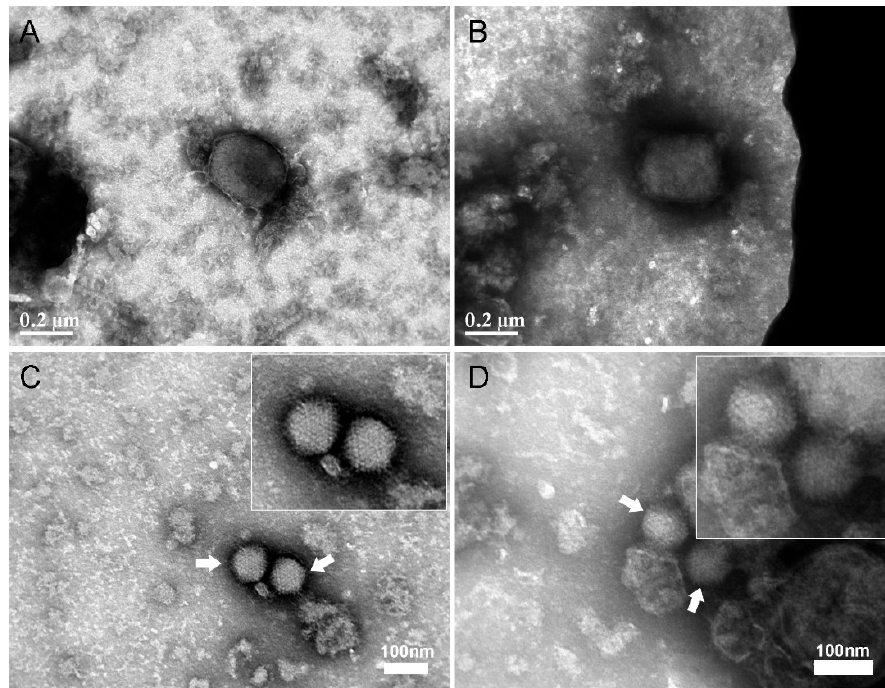
Figure 3. Negative staining TEM imaging of MVA and Adenovirus after capture and release from Vero cells. MVA and Adenovirus spiked in 2% FBS-MEM were added to Vero cells for one hour to allow attachment. After one hour, the cells (containing adsorbed viruses) were pelleted and then sonicated to release the bound viruses. The viruses were then added to TEM girds, fixed and stained with 1% PTA. ( A , B ) The traditional “brick” shape structure of MVA was seen among cell debris. ( C , D ) The icosahedral Adenovirus particles could be observed among cell debris. Representative images are from two experiment in biological duplicates. Insets shows high magnification of the viruses marked with two white arrows in panel ( C , D ).